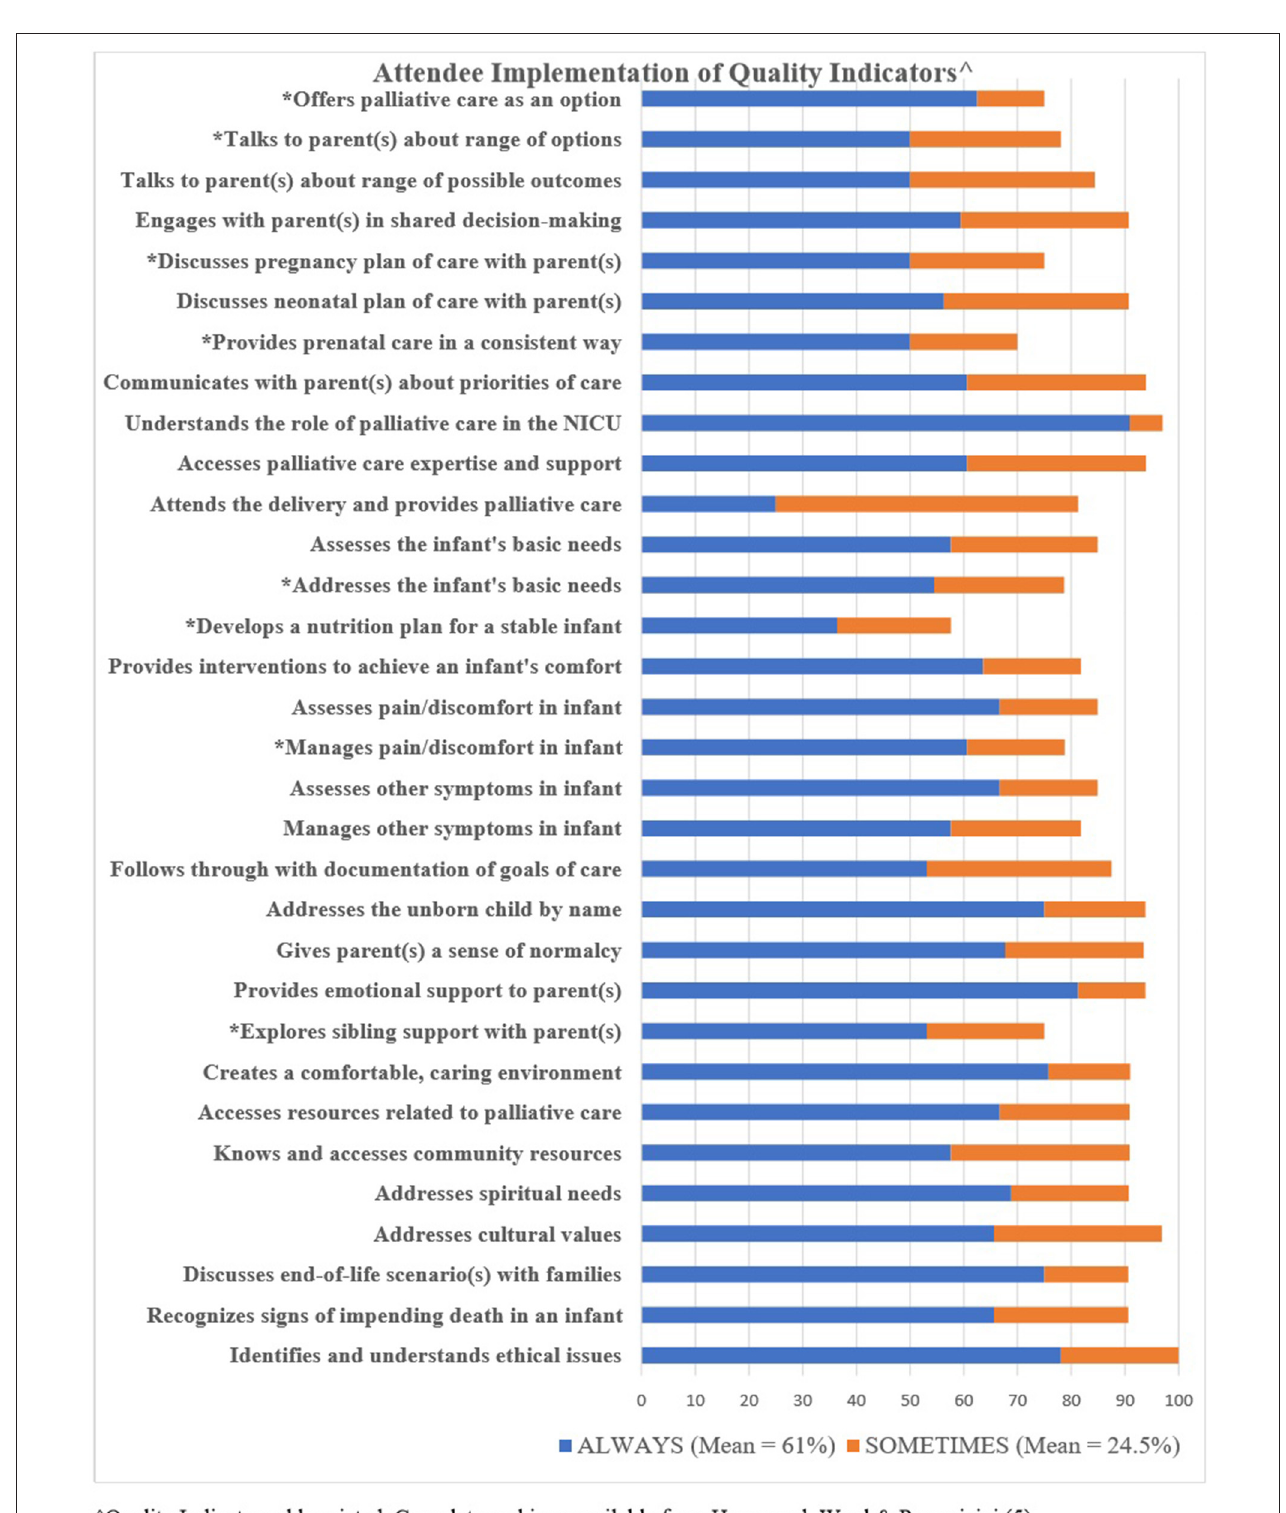
FIGURE 2 | Attendee implementation of quality